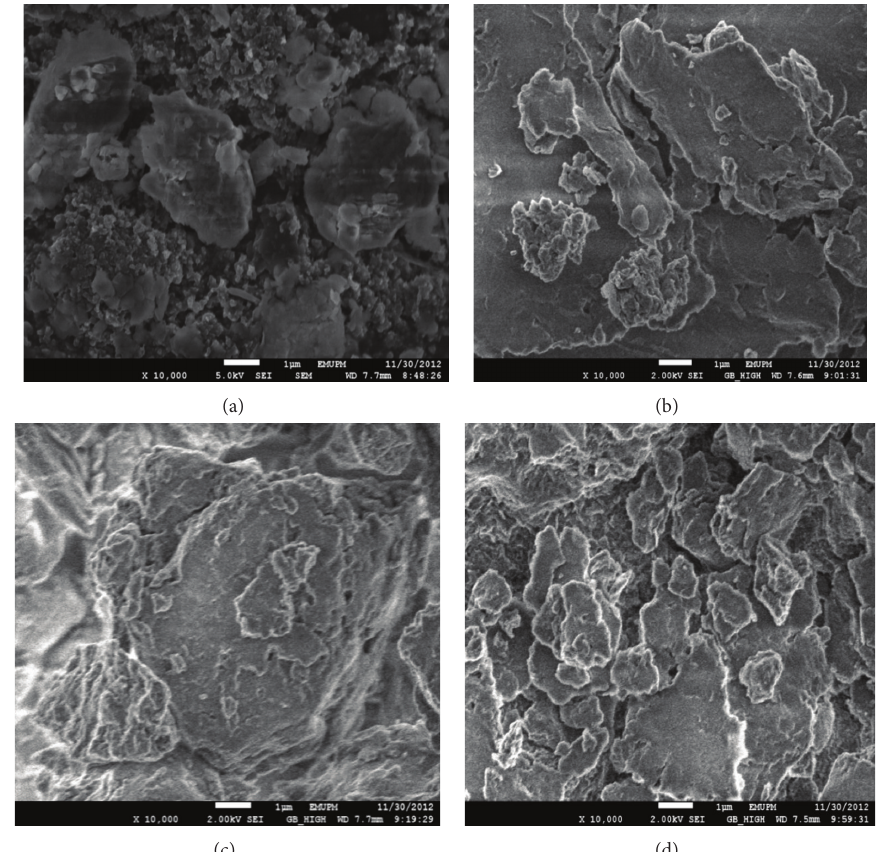
Figure 8: FESEM images of Zn4Al-LDH synthesized in the presence of (a) no SDS, (b) 0.2 MSDS, (c) 0.4 MSDS, and (d) 0.8 MSDS. observed to increase up to 90 ∘ C and decrease up to the higher